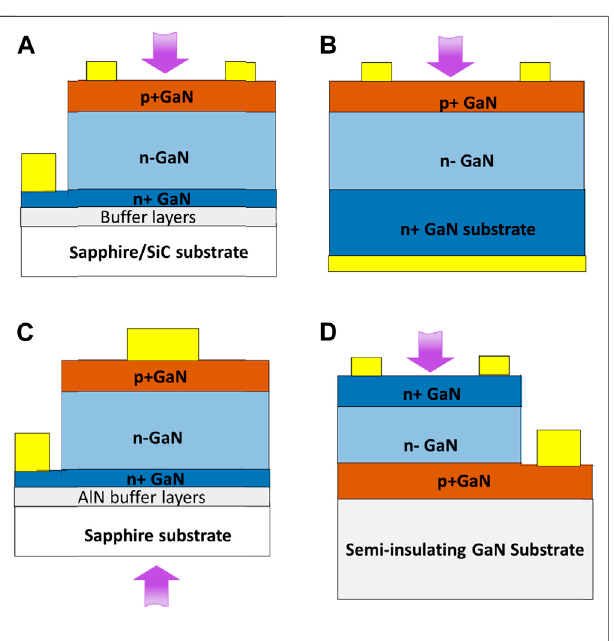
FIGURE 9 | The reported GaN APD structures: (A) front-illuminated electron-initiated APDs on sapphire or SiC substrates; (B) front-illuminated electron-initiatedAPDsonfree-standingGaNsubstrates; (C) back-illuminated hole-initiated APDs based on sapphire substrates, and (D) front- illuminated hole-initiated APDs based on free-standing GaN substrates.